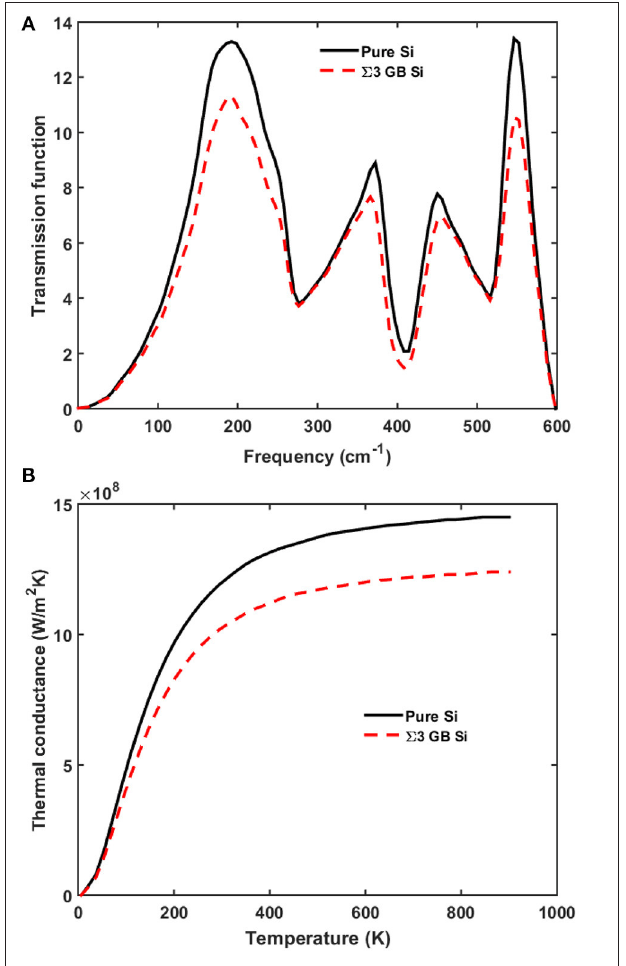
FIGURE 2 | (A) Phonon transmission, and (B) thermal conductance for pure silicon (black solid line) and silicon with perfect 6 3 grain boundary (red dashed line).